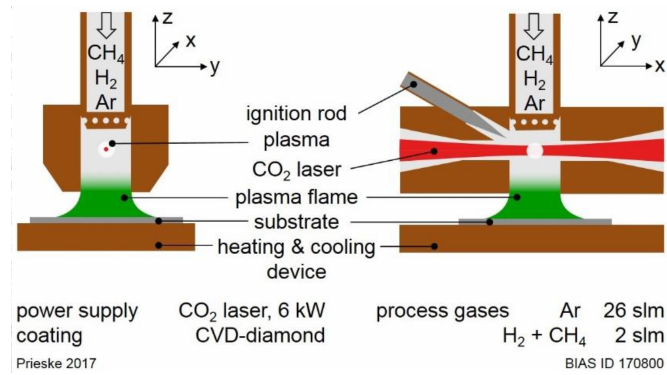
Figure 1. Schematic layout of the LaPlas CVD process at atmospheric